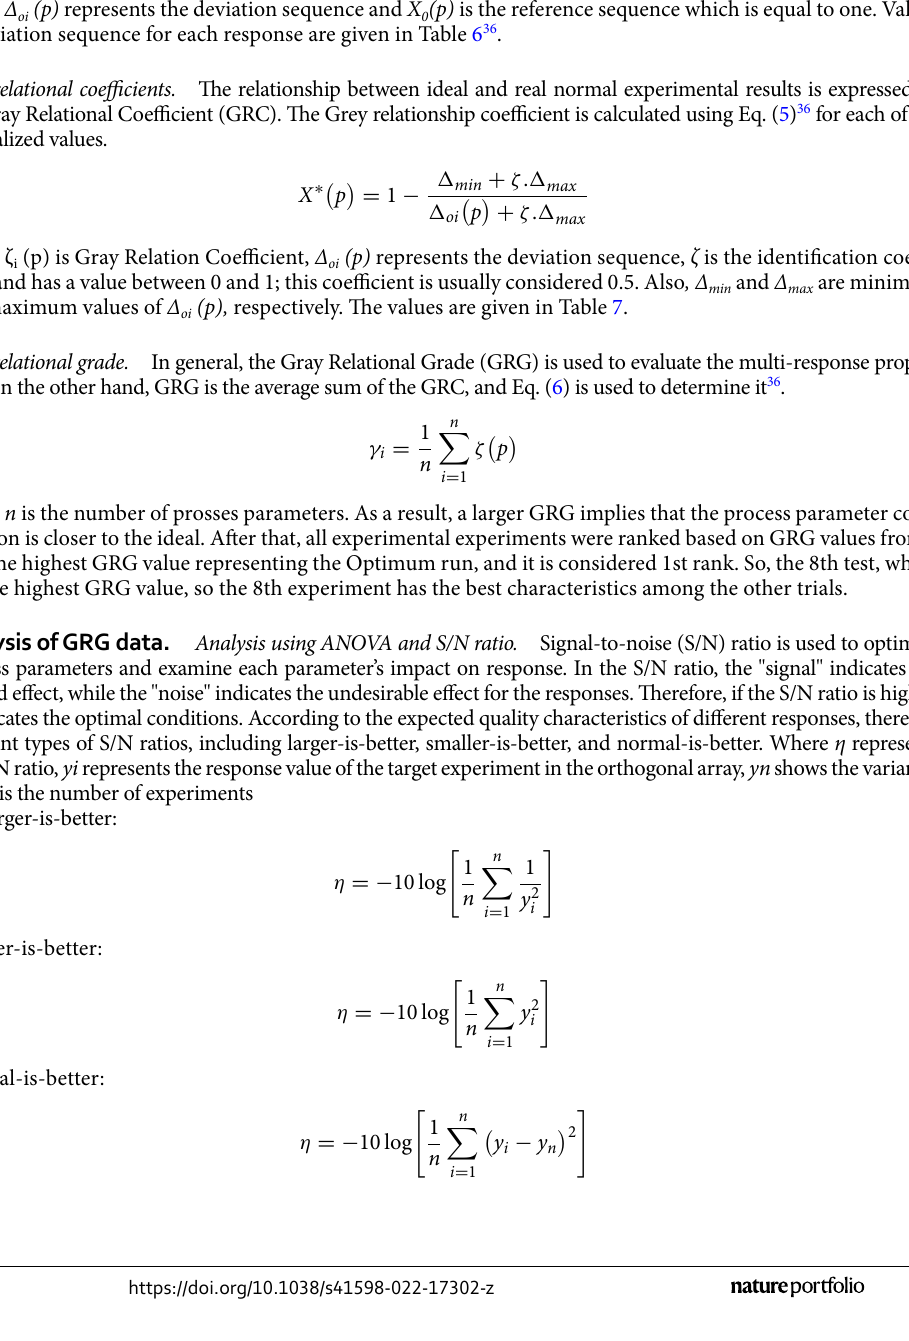
where ∆ oi (p) represents the deviation sequence and X 0 (p) is the reference sequence which is equal to one. Values of deviation sequence for each response are given in Table 6 36 . Grey relational coefficients. The relationship between ideal and real normal experimental results is expressed by the Gray Relational Coefficient (GRC). The Grey relationship coefficient is calculated using Eq. (5) 36 for each of the normalized values.